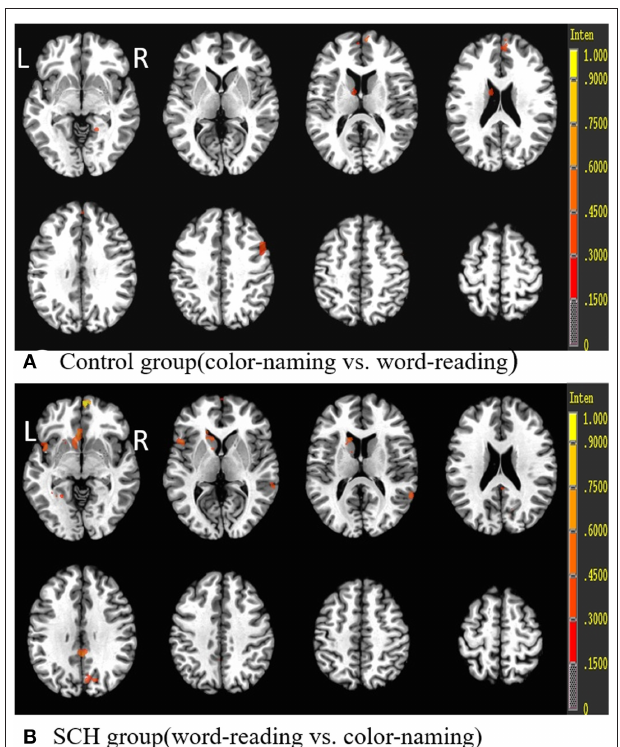
FIGURE 4 | Brain activation differences during the Stroop task (color-naming vs. word-reading or word-reading vs. color-naming) in both groups. R, Right; L,